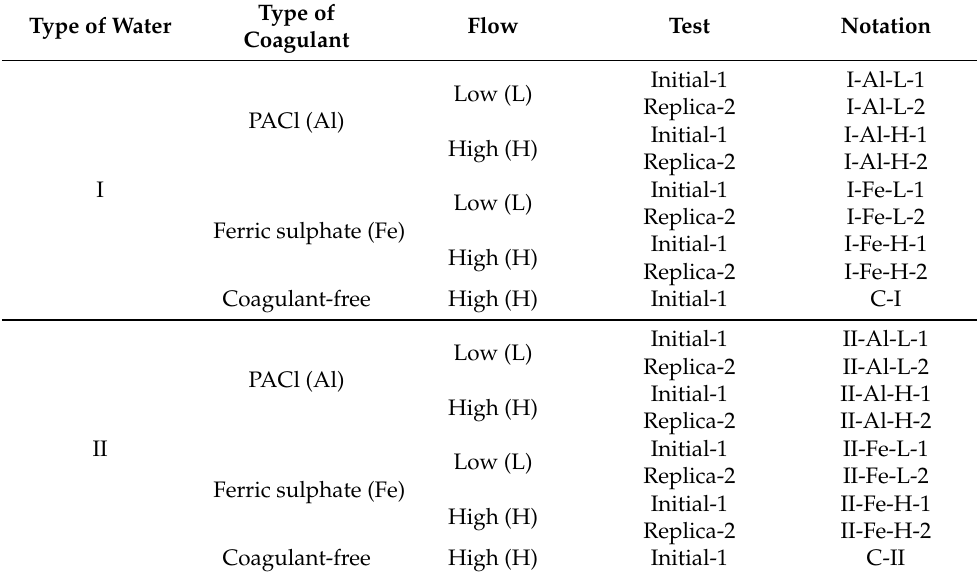
Table 3. Description of treatments and